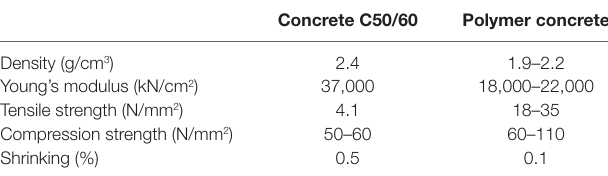
Table 2 | Material properties of conventional concrete and polymer concrete (Osman et al.,